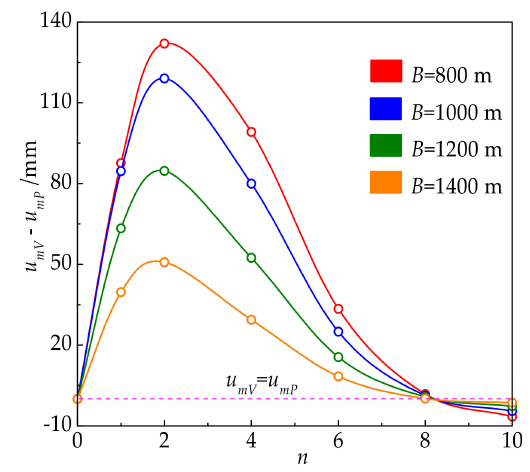
Figure 13. Di ff erence of u m between the two models with